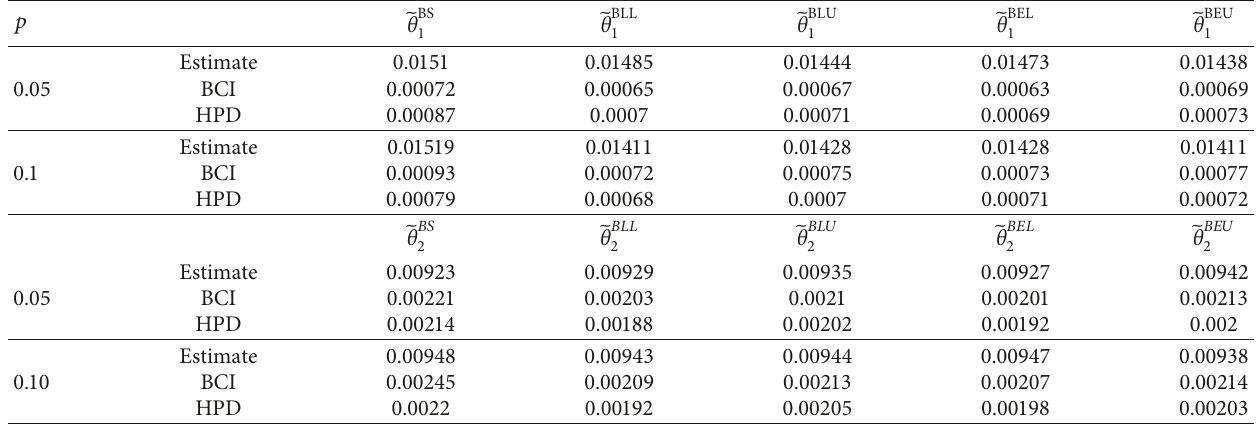
Table 21: Bayes estimate of parameter and parametric function with their confidence intervals.